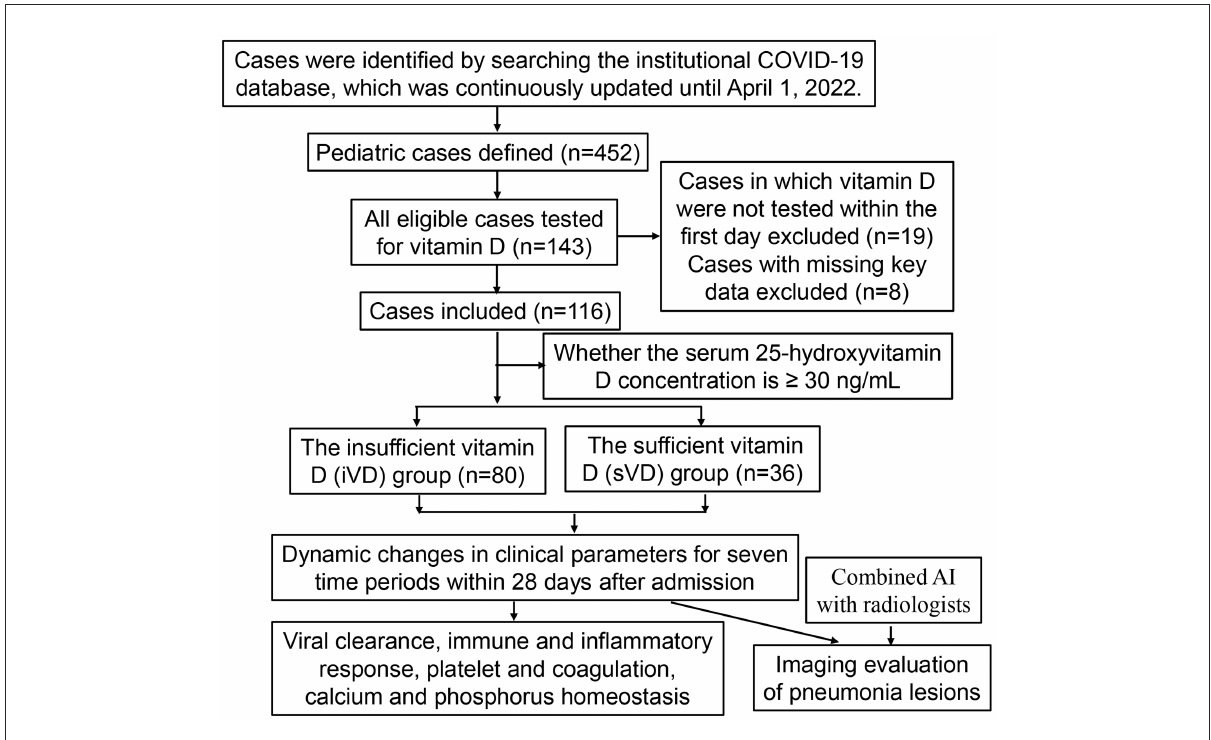
FIGURE1 Flow chart of the pediatric cases selection and analysis